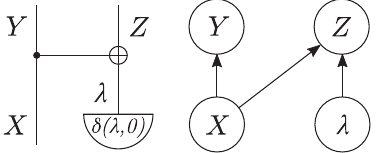
FIG. 8. Classical realization of a copy operation using an ancilla and classical CNOT gate.